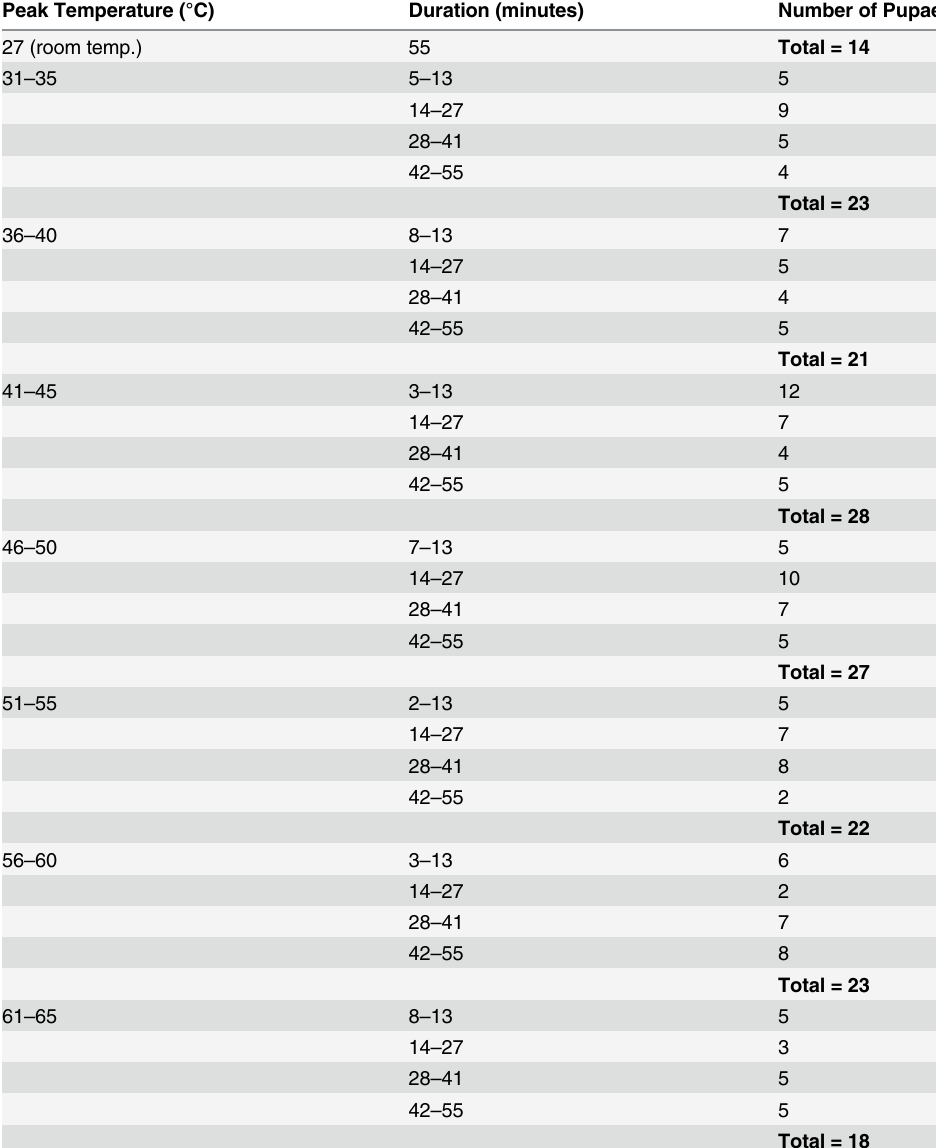
Table 1. Experimental treatment setup for initial water bath experiment using E . atala pupae. Peak Temperature (°C) Duration